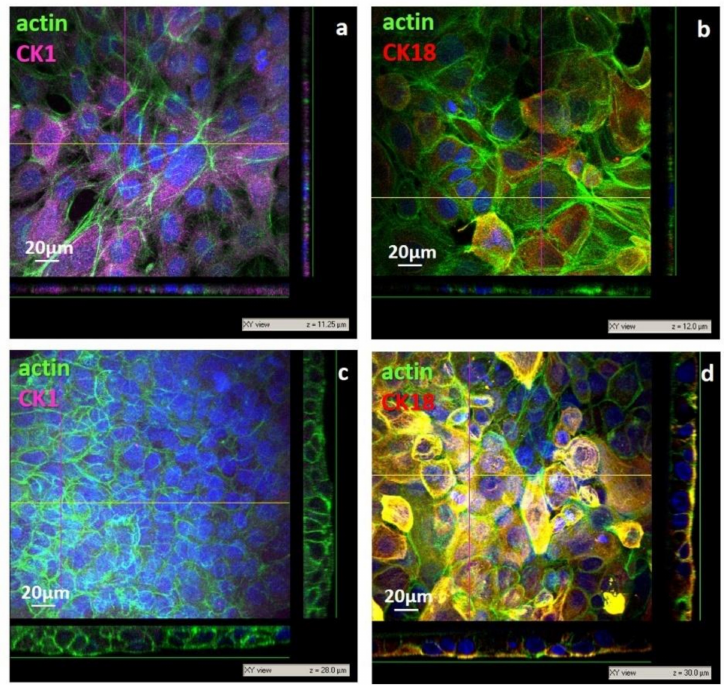
Figure 6. CLSM images of primary human keratinocytes after 3 days of culture on nanoporous chiosan (np CHT) ( a , b ), and microporous chitosan (mp CHT) ( c , d ) membranes: xy views and relative xz and yz projections along z axis, with relative thickness values ( µ m). Cells were visualized for actin (green), CK1 (magenta), CK18 (red) and nuclei